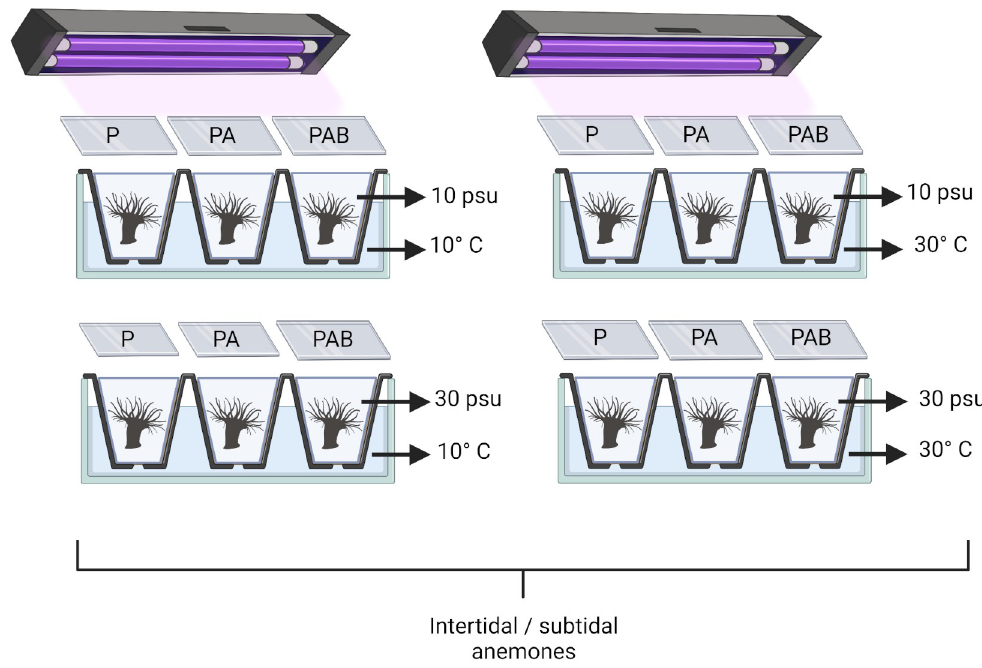
Fig 2. Anthopleura hermaphroditica . Experimental setup of the multifactorial experiment where intertidal and subtidal anemones of A . hermaphroditica were exposed to a combination of temperatures (10˚C and 30˚C), salinity (10 and 30 ppt), and radiation (P: PAR, PA: PAR+UV-A, and PAB: PAR+UV-A+UV-B) for 0, 24 and 48 h. Diagram was created using BioRender